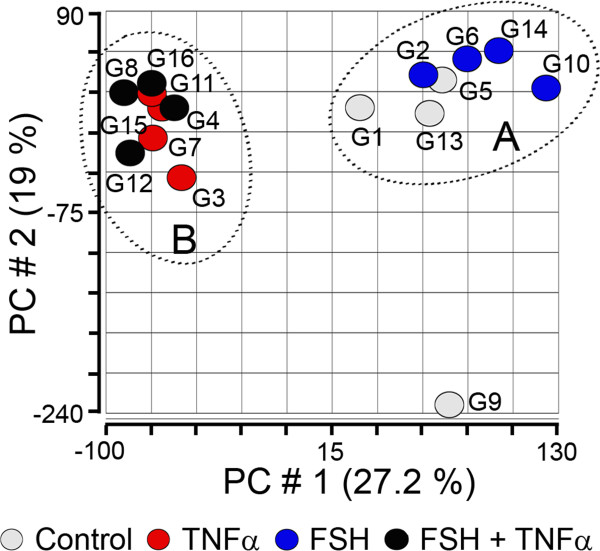
Unsupervised PCA of the granulosa cell arrays using Partek. The arrays are numbered (n = 4 per treatment) as follows: control granulosa (G1, G5, G9 and G13 in grey); FSH-treated (G2, G6, G10 and G14 in blue); TNFα-treated (G3, G7, G11 and G15 in red) and TNFα plus FSH-treated (G4, G8, G12, and G16 in black). The graph is a scatter plot of the values for the first (X) and second (Y) principal components based on the correlation matrix of the total normalised array intensity data. The groups of arrays (A) and (B), encircled by the dotted lines, represent related arrays based on patterns of total gene expression determined from the PCA. The G9 array had a considerably different pattern of gene expression from all the others and was therefore considered to be a statistical outlier and excluded from further analysis.